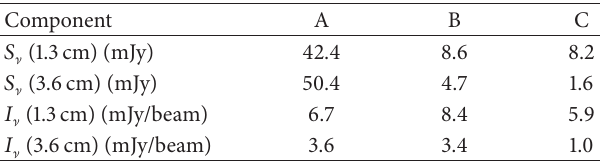
Table 1: Total flux and peak intensity for each component of G75.78+0.34 at 1.3cm and 3.6 cm.